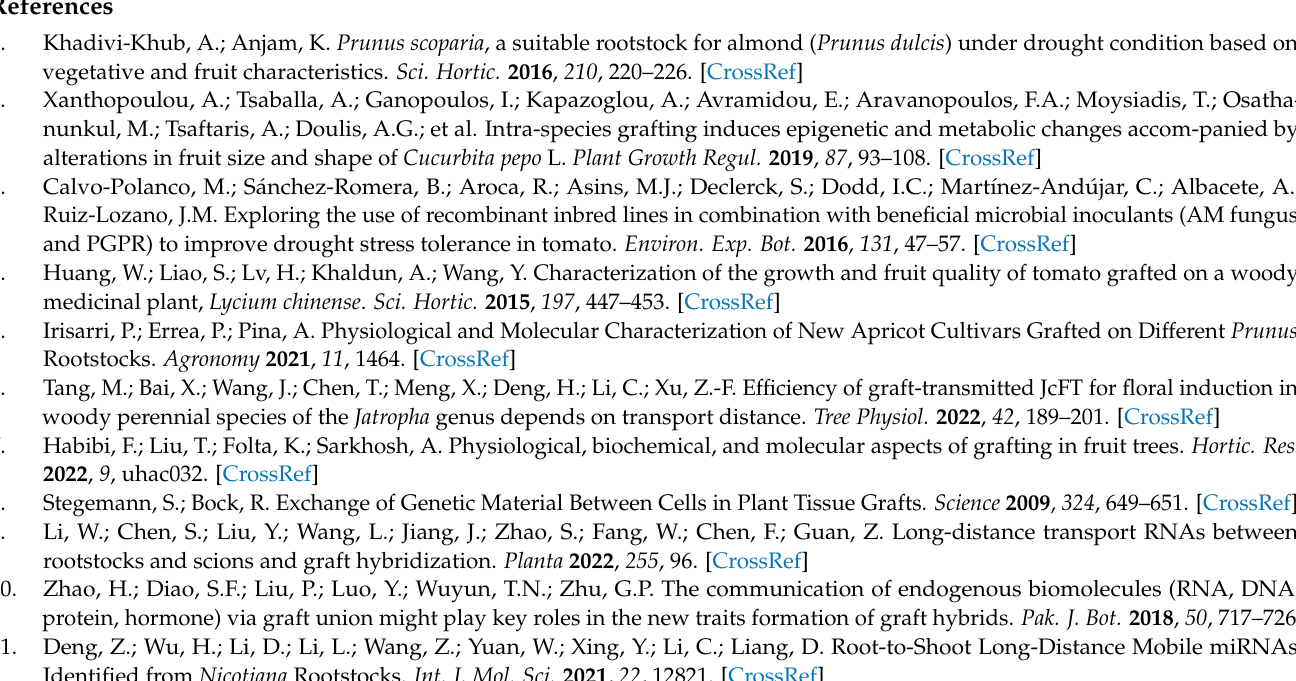
Table S2. Statistics of transcript data (raw data, valid data, Q20%, Q30%, etc.) of nine samples. Table S3. Statistics and analysis of all identified